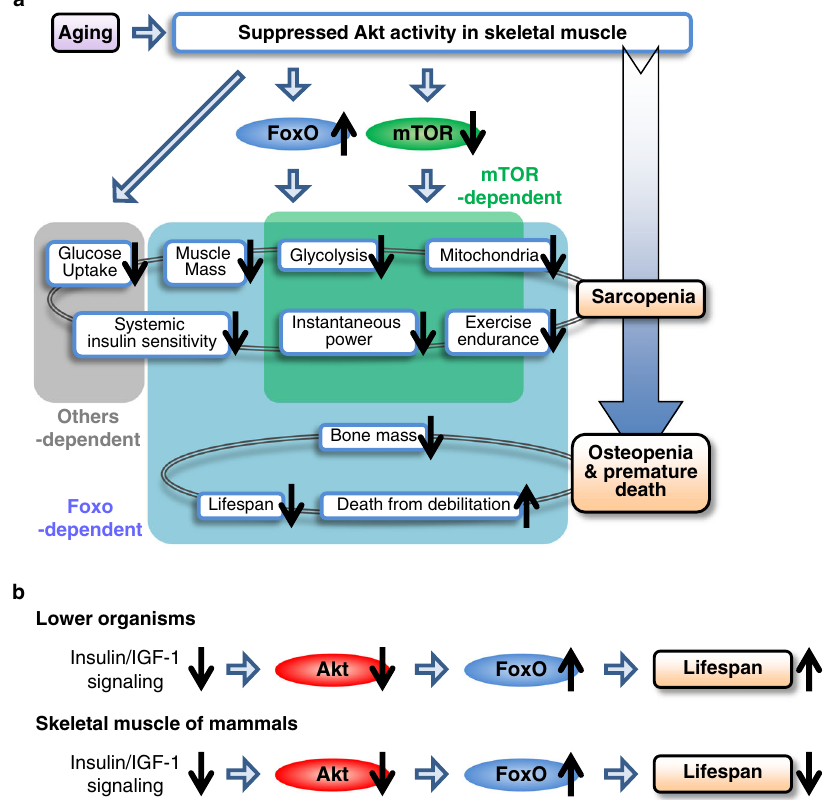
Fig.9|Schematicsummary.a RoleofAktinskeletalmuscleinprotectionagainstsarcopenia,osteopenia,andreducedlifespaninmice. b Effectsofimpairedinsulin/IGF- 1 signaling on lifespan in lower organisms and in skeletal muscle of